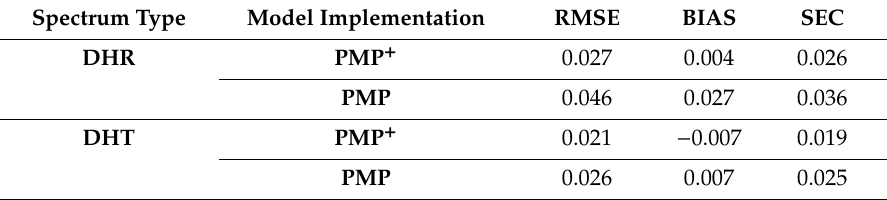
Table 4. Global performance evaluation of simulated leaf spectra from PROSPECT-MP + (PMP + ) and Square Error, Bias and Standard Error Corrected for the errors between the measured and modeling spectra, respectively.